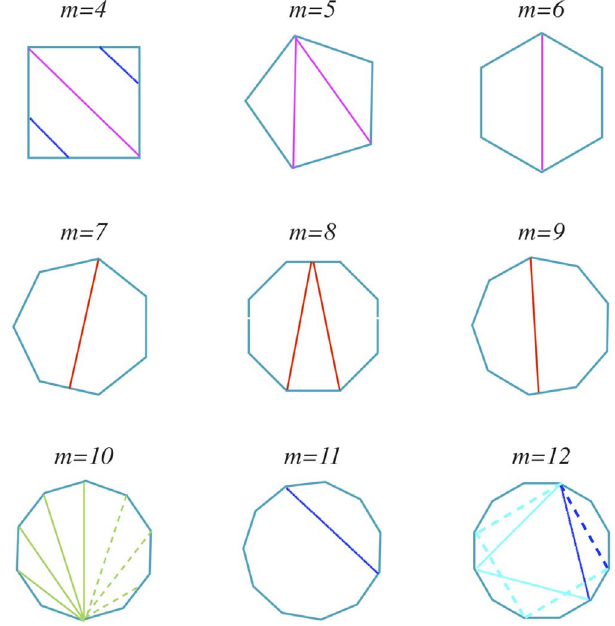
Figure 36. Understanding modes of